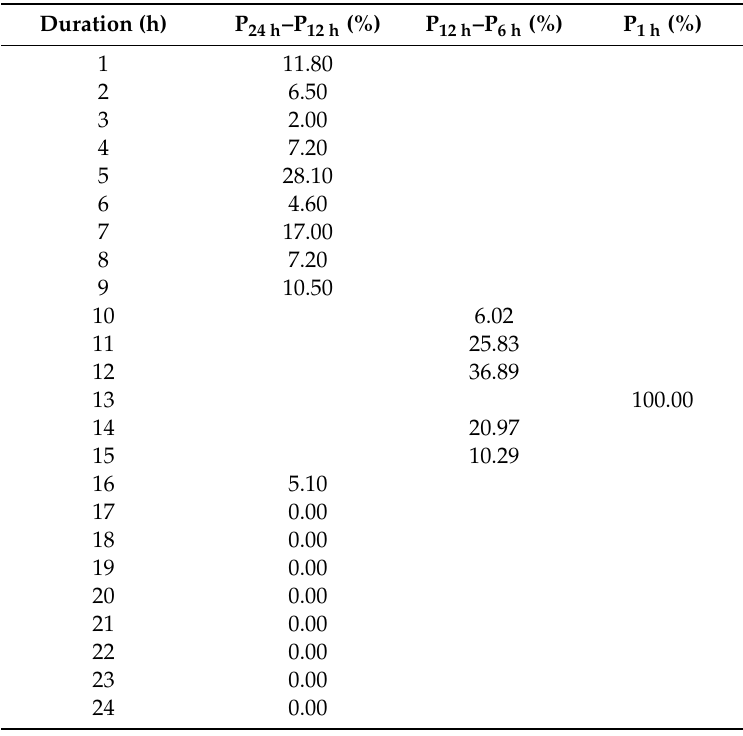
Table 8. The distribution of designed rainfall in 24